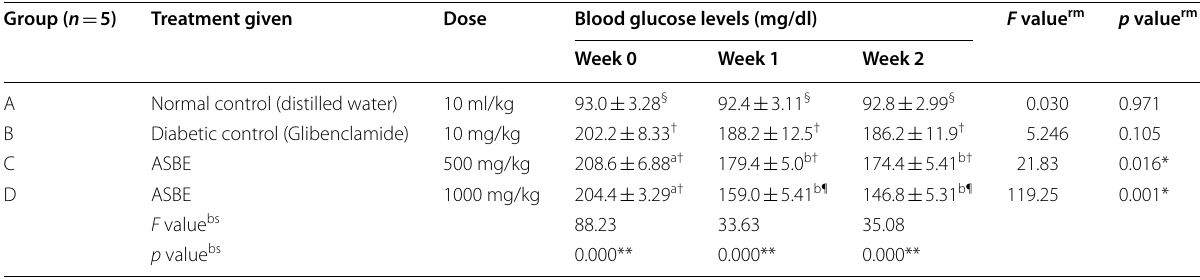
Values are presented in mean SEM; ASBE, aqueous stem bark extract of B. dalzielii ; values in the same row having different letters (a, b) of alphabets or values in the ± same column having different special characters (§, †, ¶) are statistically significant * p < 0.05 rm Analyzed with repeated measures ANOVA bs Analyzed with between-subjects ANOVA